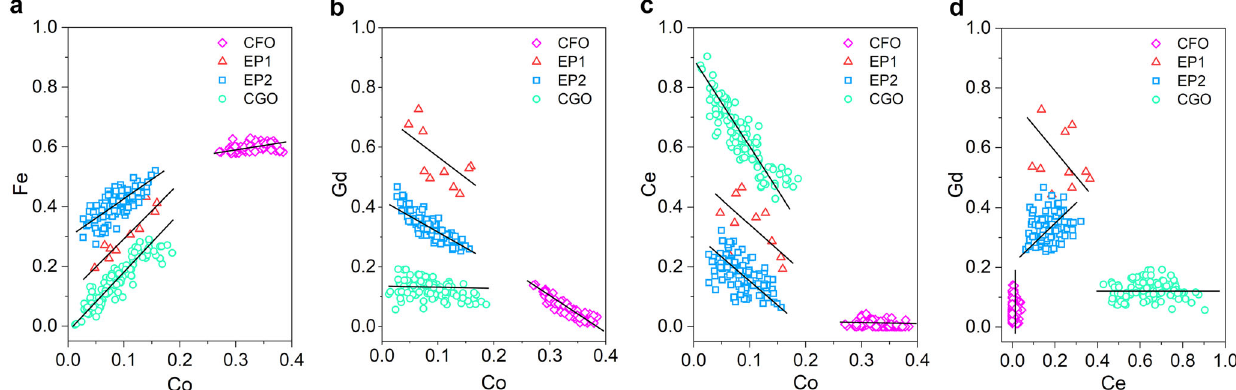
Fig. 5 Linear fi tting analysis of the metal concentration to determine the composition of the four material phases in CGO-CFO MIEC system. Fe vs. Co ( a ). Gd vs. Co ( b ). Ce vs. Co ( c ). Gd vs. Ce ( d ). For each panel, the data for EP1 are shifted vertically by 0.1 to provide good data visibility. The solid lines are the linear fi ts to the data. The following is the summary of the linear fi tting results. For CFO, [Fe] = 0.48 + [Co]/3, [Gd] = 0.51 – 4[Co]/3, and [Ce] = 0.01±0.01 for 0.27<[Co] < 0.37. For CGO, [Fe] = 2[Co], [Gd] = 0.13± 0.13, and [Ce] = 0.88 – 3[Co] for 0 < [Co] < 0.19. For EP1, [Fe] = 2[Co], [Gd] = 0.61 – 3[Co]/2, and [Ce] = 0.39 – 3[Co]/2 for 0.05<[Co] < 0.16. For EP2, [Fe] = 0.28 + 3[Co]/2, [Gd] = 0.42-[Co], and [Ce] = 0.3 – 3[Co]/2 for 0.02<[Co] < 0.16. Typical fi tting errors are ~0.02 for the linear term and ~0.03 for the constant term. Determinming the composition of EP1 and EP2 is somewhat tricky since EP1 and EP2 donot contain any element witha constant concentration. Inaddition,the correlation between Gdand Ce istoo poorto perform the reliable fi tting.By fi ttingthe datasets with better linear correlations (Fe vs. Co, Gd vs. Co, and Ce vs. Co), we deduce the linear trend between Gd and Ce shown in d , over which the data points are highly